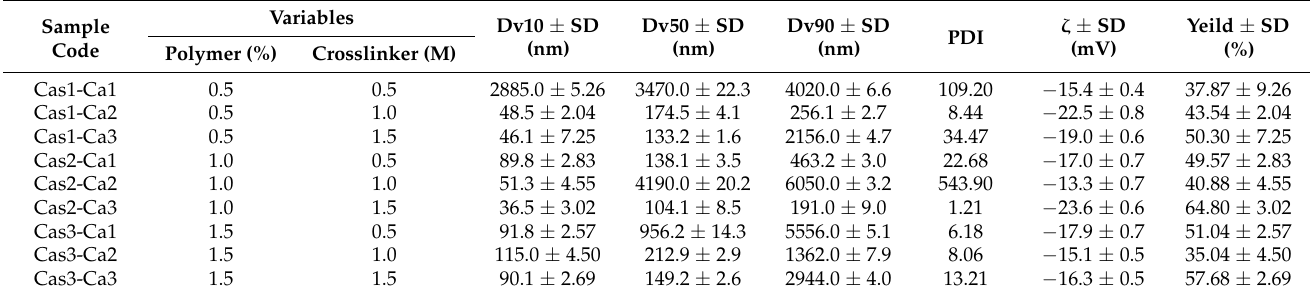
Table 1. Composition and characteristics of blank casein nanoparticles (n = 3, PDI (polydispersity index), Dv10, Dv50 and Dv90 (10, 50 and 90% of the total volume of particles, respectively, are with size below the indicated value). Sample Code